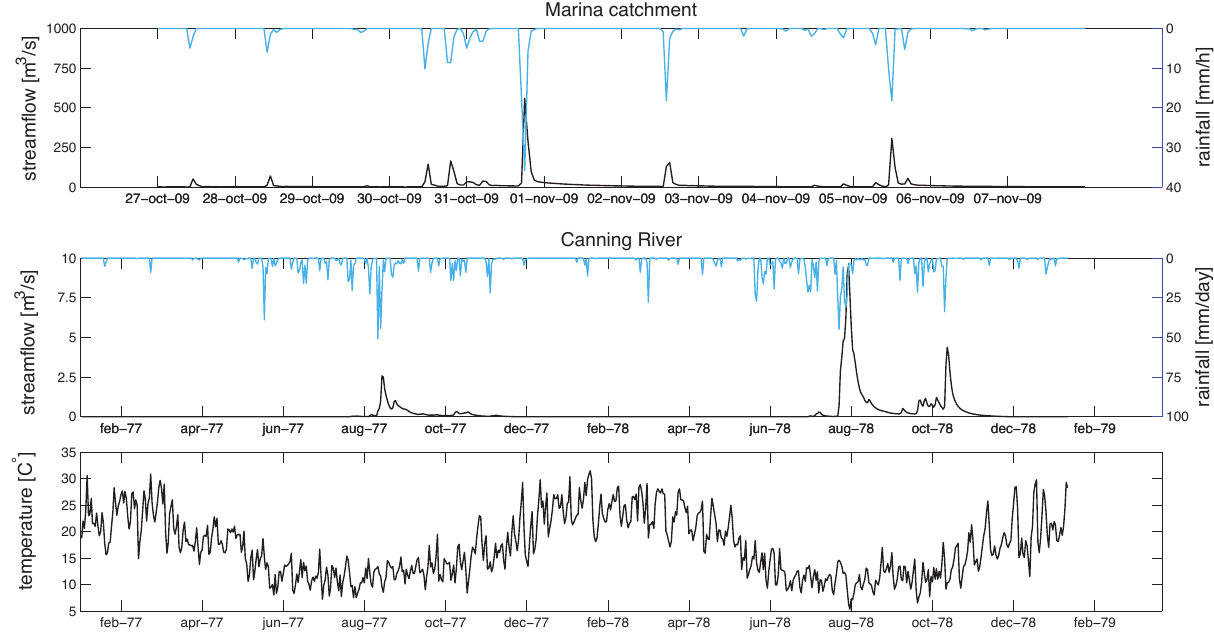
Fig. 1. Specimen of the hydrograph generated in Marina catchment and Canning River under different rainfall (and temperature)